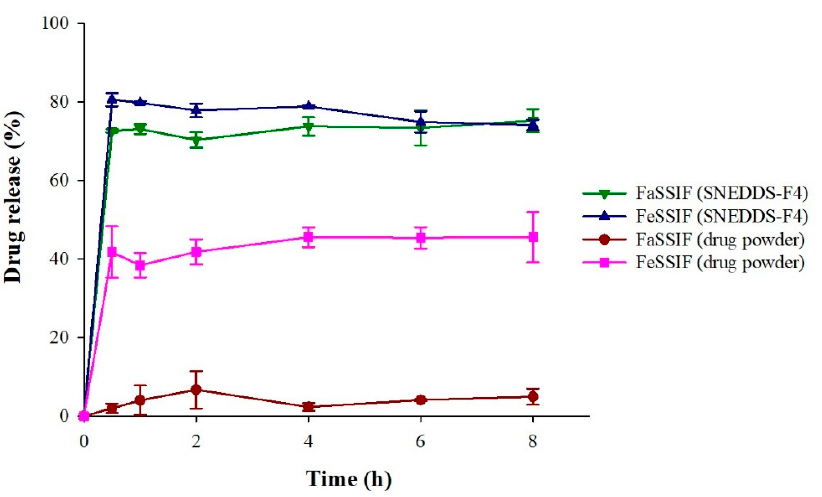
Figure 7. Drug release profiles of SNEDDS-F4 and drug powder in FaSSIF and FeSSIF (mean ± SD, n =